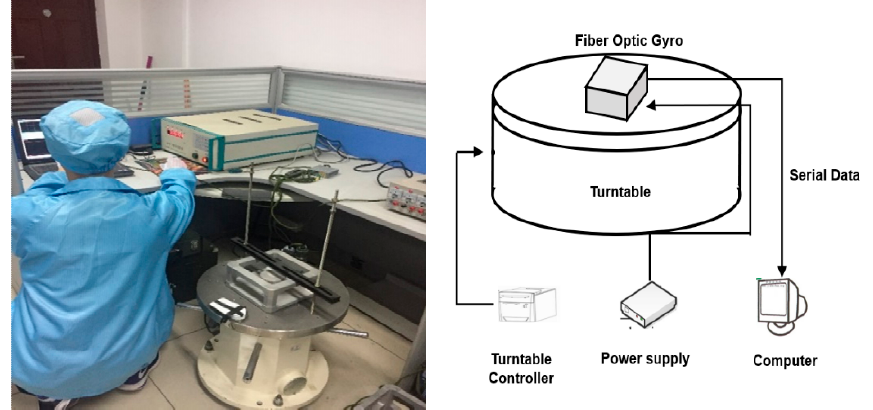
Figure 4. Fiber optic gyroscopes and construction of the turntable test.